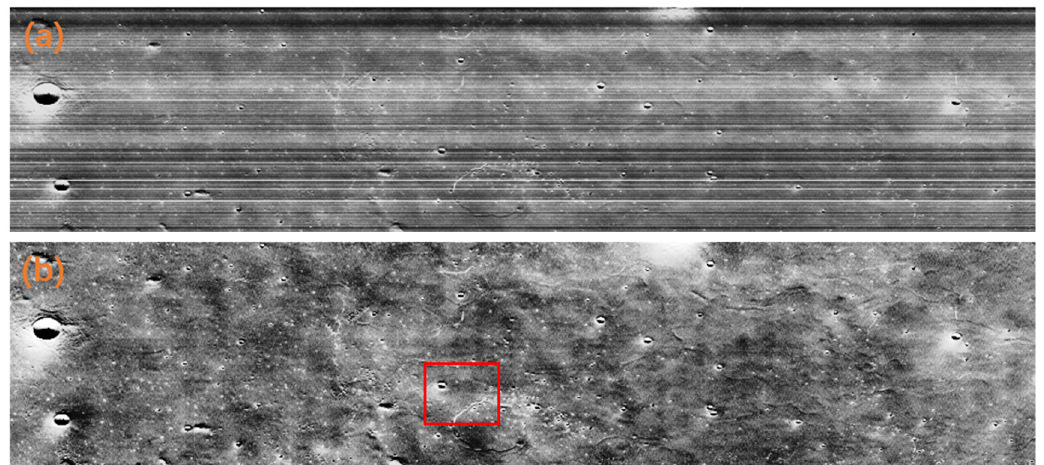
Figure 15. MMS image (central wavelength of 1931.64 nm) with Gaussian stretching ( a ) before correction and ( b ) using the proposed method. The image was rotated, and the frame shows the Zhurong Mars rover landing zone.